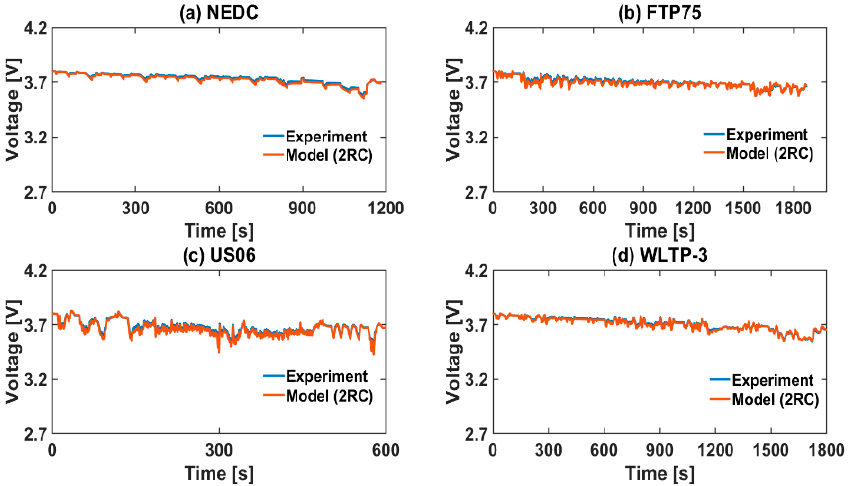
Figure 9. Comparison between experimental and modelling (2RC) voltage profiles for current-based approach at 25 °C ambient temperature and 65% starting SOC: ( a ) NEDC, ( b ) FTP75, ( c ) US06 and ( d ) WLTP-3.